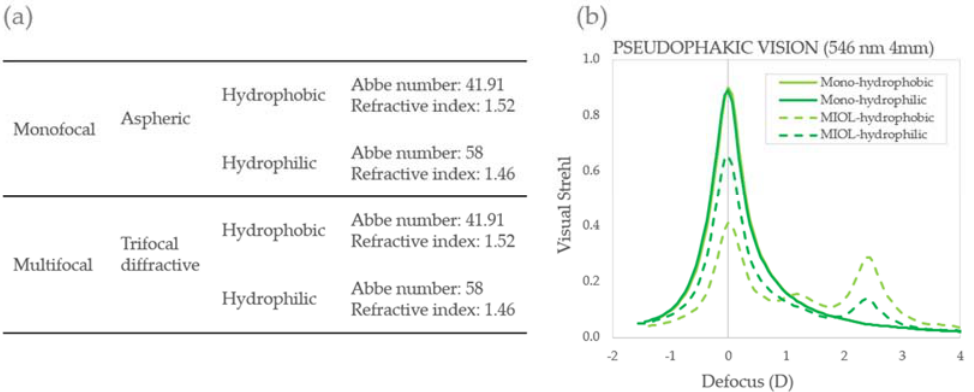
Figure 1. Intraocular lenses. ( a ) Material and designs characteristics for all IOLs; ( b ) monochromatic optical quality metric (546 nm) in the form of Visual Strehl (4 mm) for all four IOLs: mono-hydrophobic (solid light green); MIOL-hydrophobic (dashed light green); Mono-hydrophilic (solid dark green); MIOL-hydrophilic (dashed dark green).